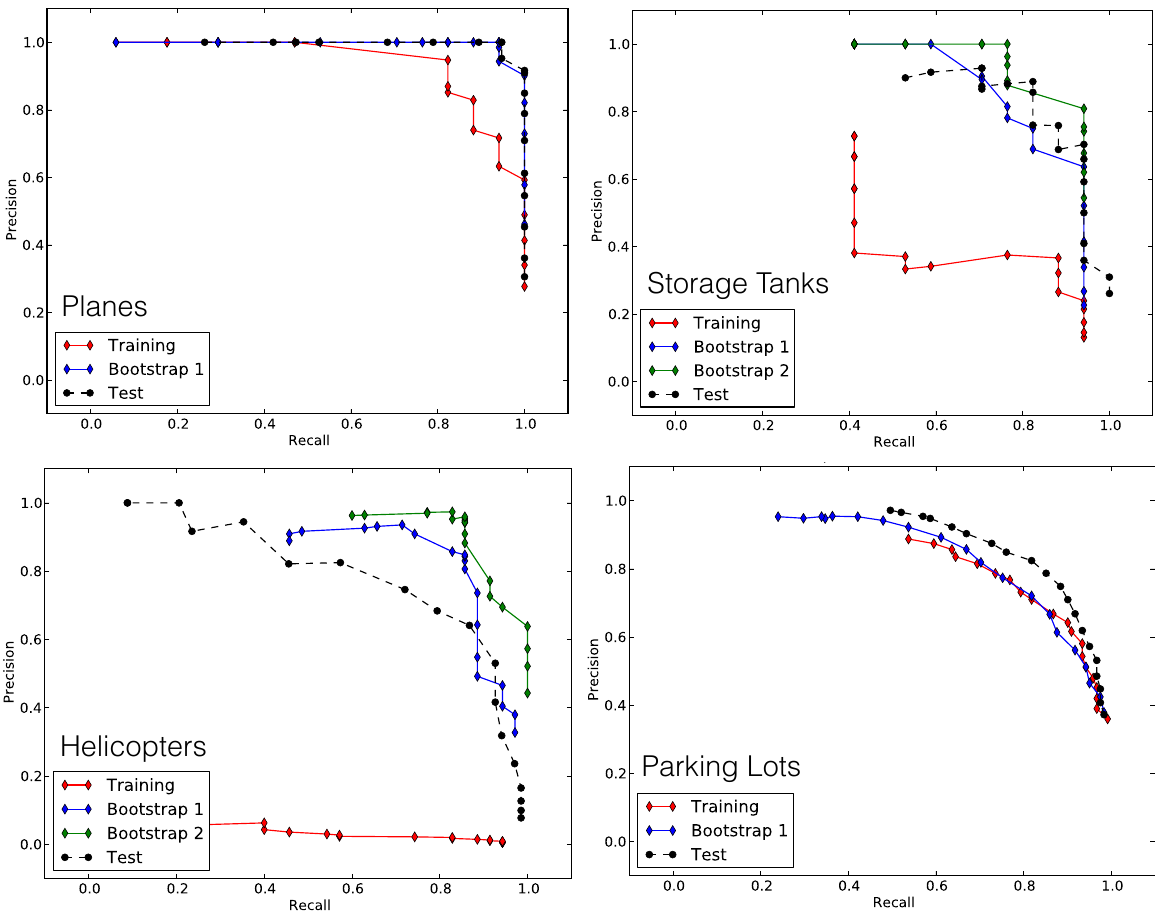
Figure 6: Precision-recall curves for McChord AFB data set. Two rounds of bootstrapping were used with helicopters and storage tanks, and only a single round for planes and parking lots. Bootstrapping does not seem to help parking lots, perhaps because there were many more initial positive training samples (over 12,500 parking lot samples vs. about 2,000 each for the other